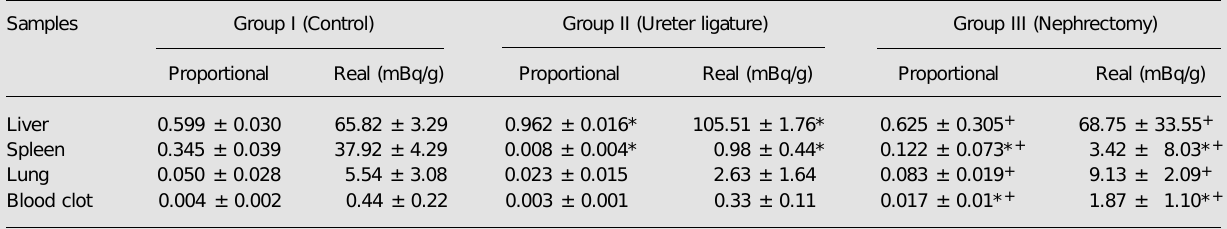
Table 3. The proportional and real values of radioactivity ( 99m Tc sulfur colloid - 110 mBq) in the mononuclear phagocytic system organs and blood of rats with renal and postrenal